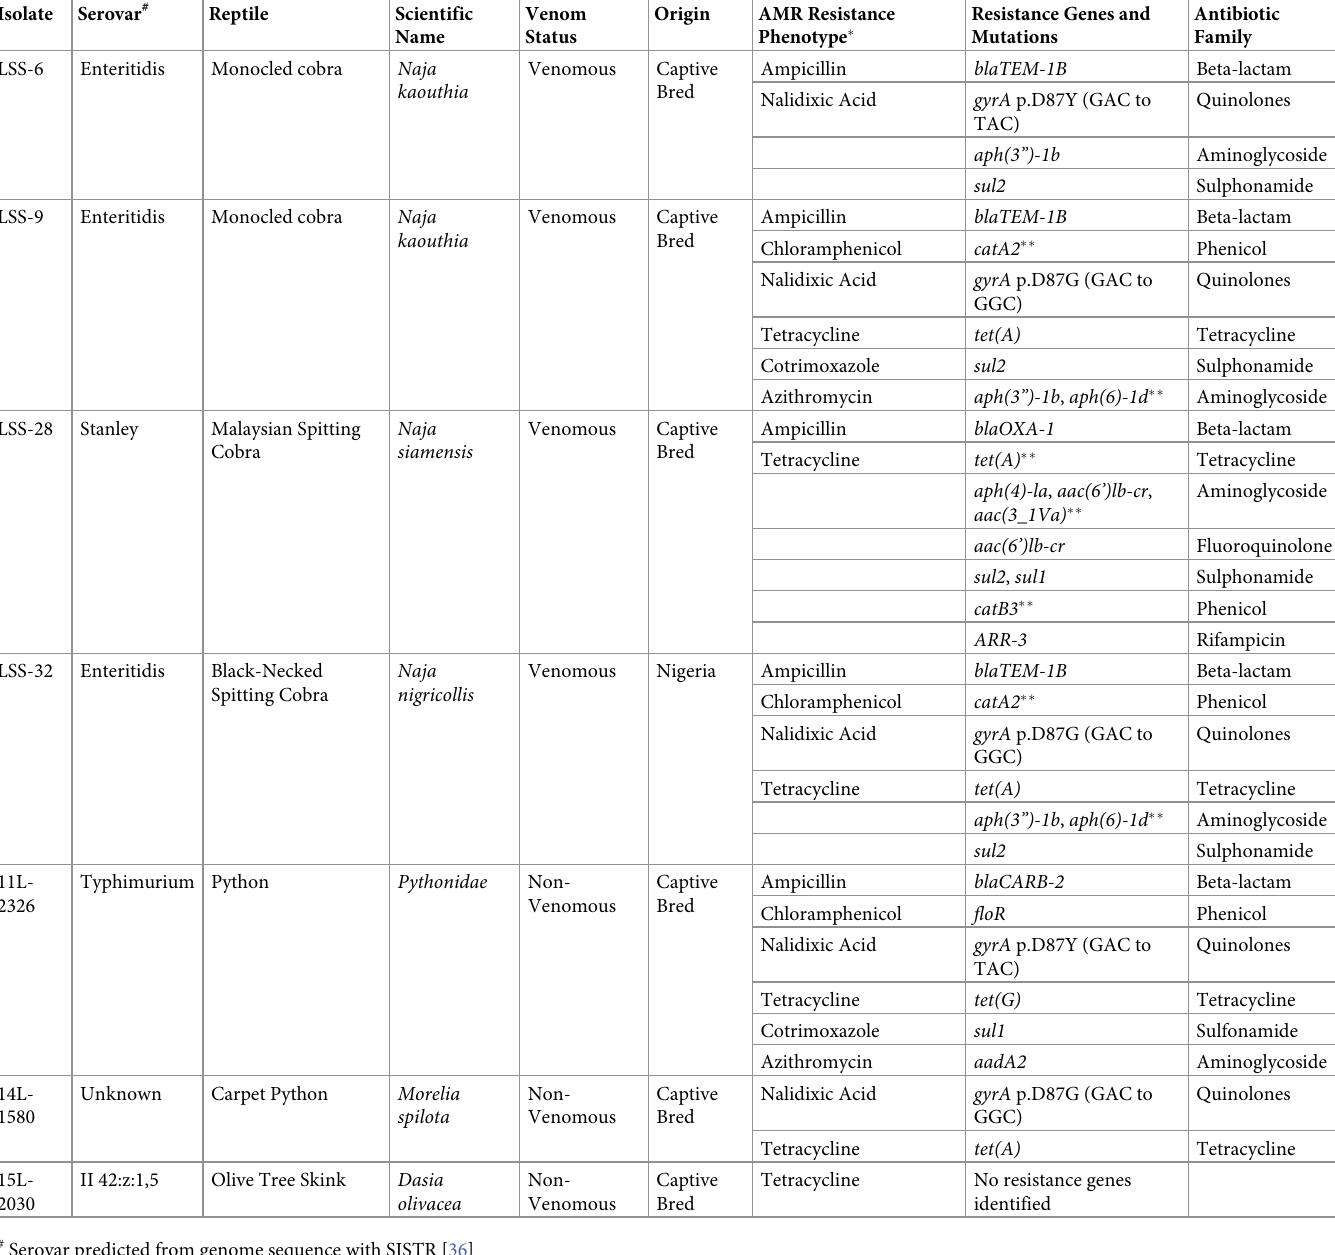
Table 2. Relating antimicrobial resistance to phenotype and